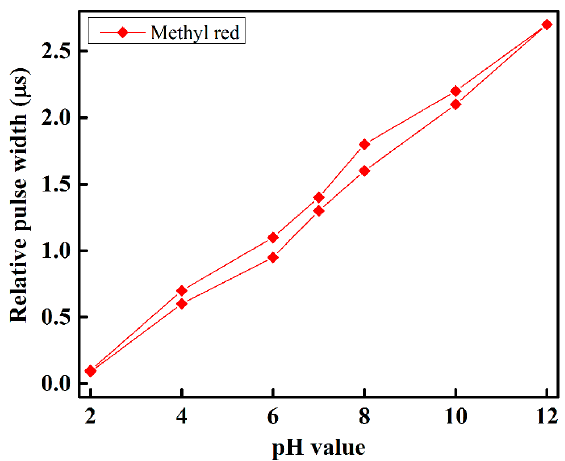
Figure 8. The hysteresis response of methyl red containing sensing element of the array.